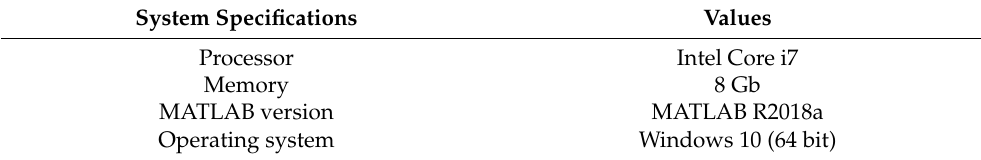
Table 1. Implementation